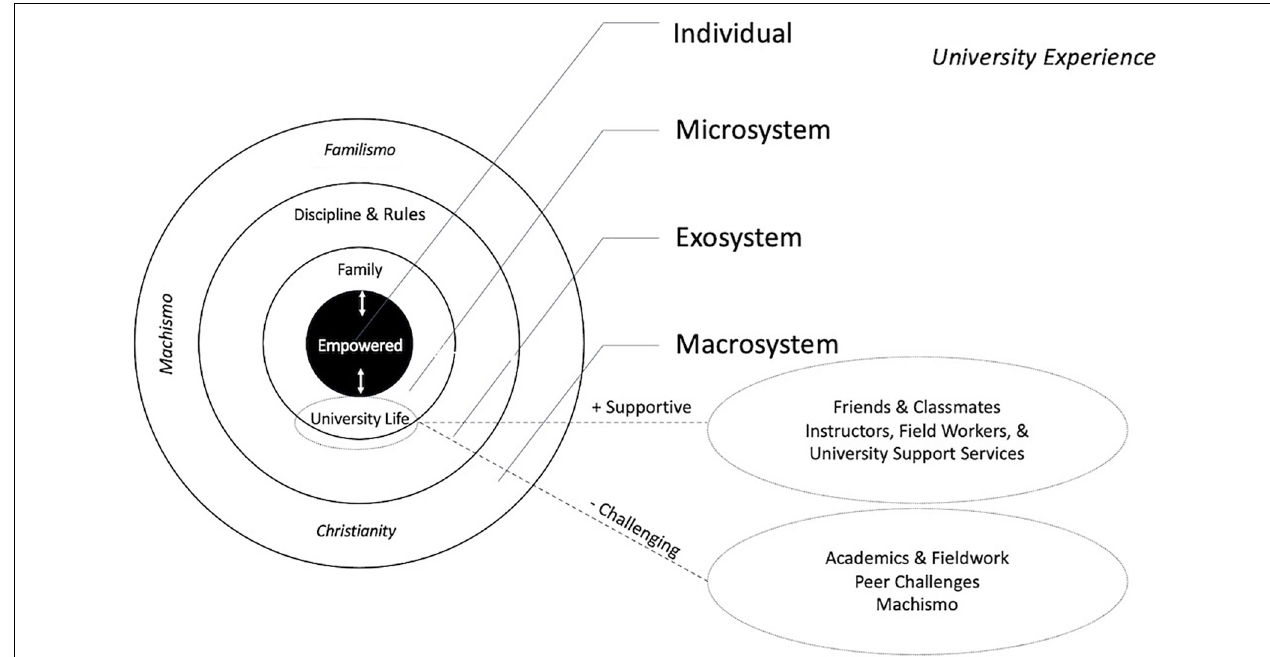
FIGURE 3 | Depicts the ecological systems of the student during her studies at the